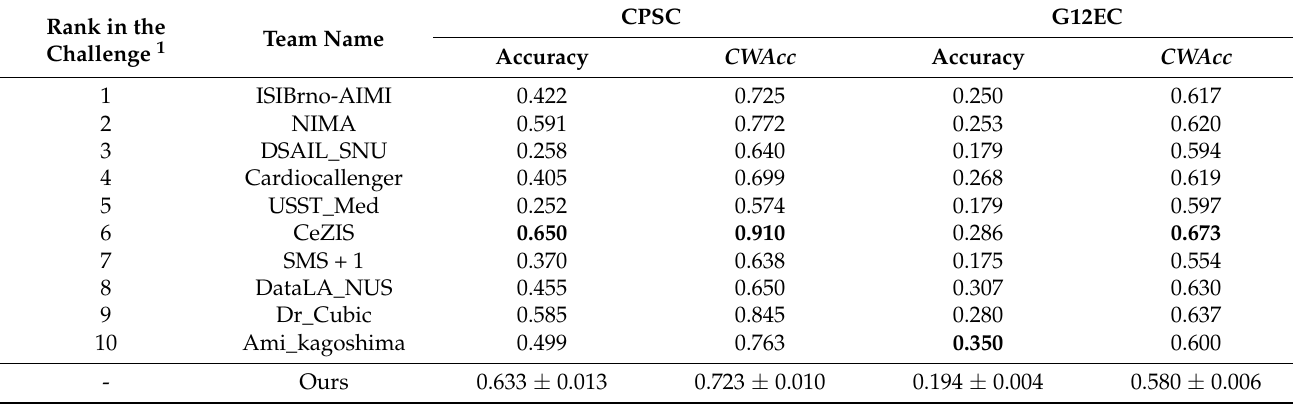
Table 3. The public results on the China Physiological Signal Challenge (CPSC) and the Georgia 12-lead ECG challenge (G12EC) test sets and the modified 5-fold cross-validation results (mean ± std) of our method on the training sets of CPSC and